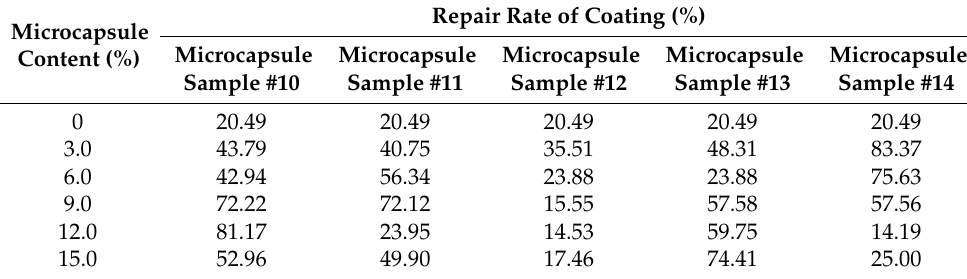
Table 11. Results of the repair rate of waterborne coatings with different